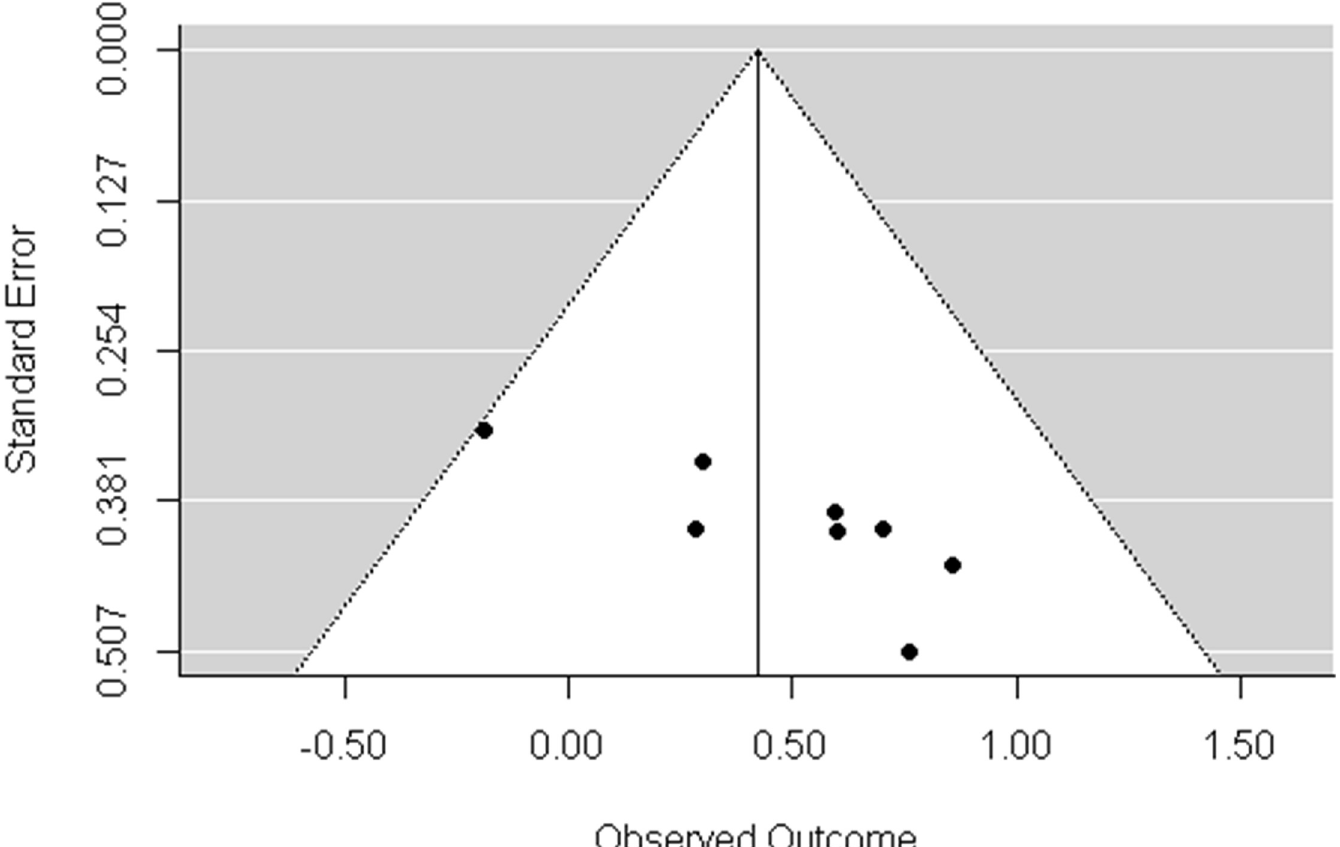
Fig 4. Funnel plot for HR of OS and liver metastasis. Funnel plot shows the absence of studies with a greater number of patients than the mean analyzed.